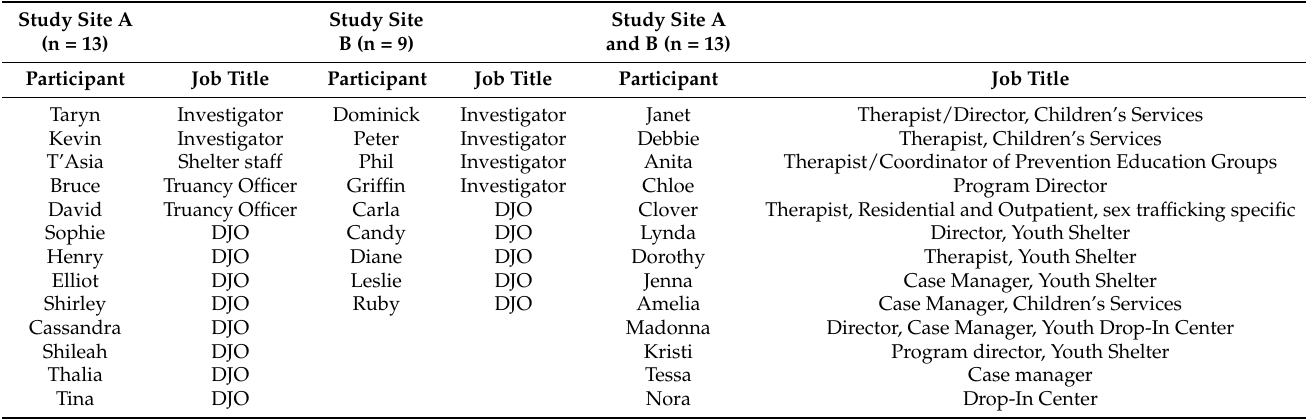
Table 1. Study Site Participants and Job